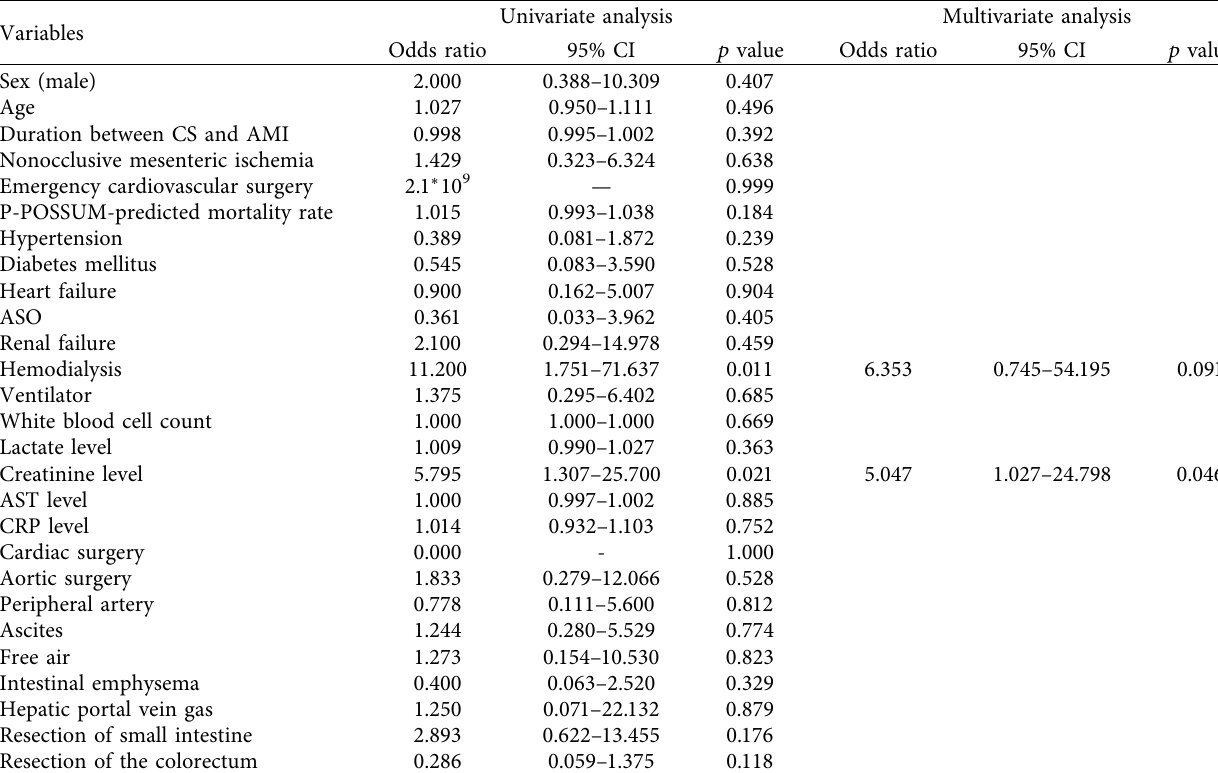
Table 3: Multiple logistic regression analysis of in-hospital